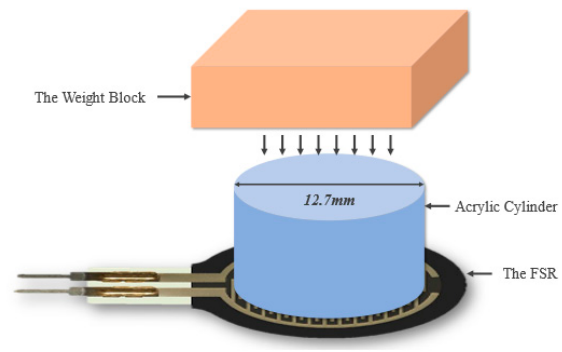
Figure 4. Characterization setup of the FSR system.